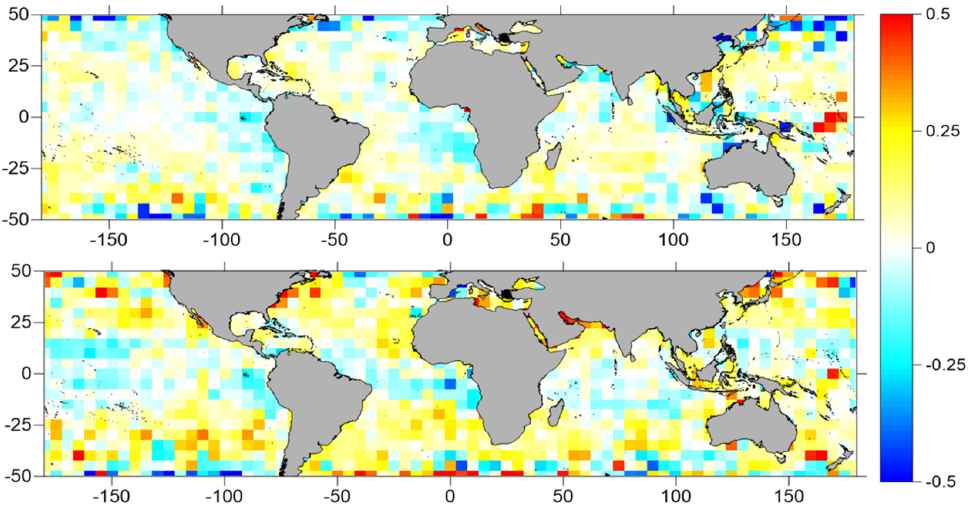
Figure 5. Differences, in cm, between RMS values for Algorithms 1–3 ( top panel), and Algorithms 2–4 ( bottom panel), represented with a 5° by 5° spatial resolution.